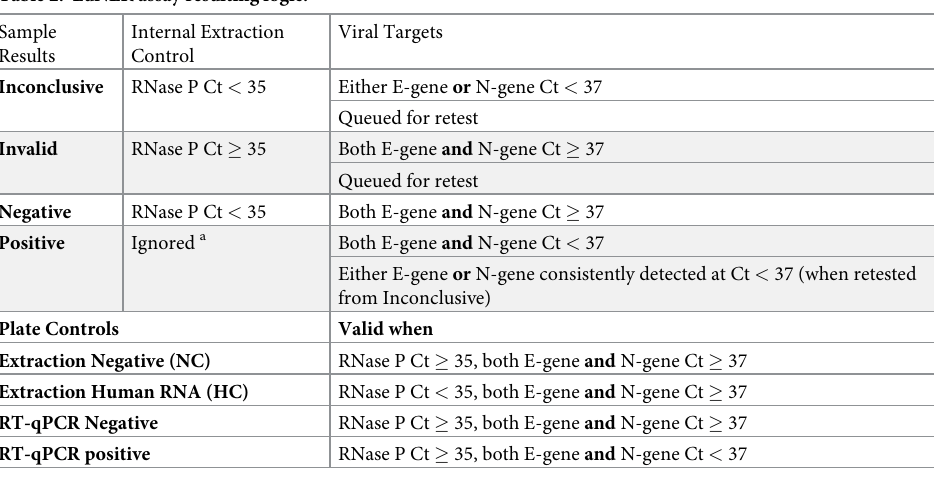
Table 2. LuNER assay resulting